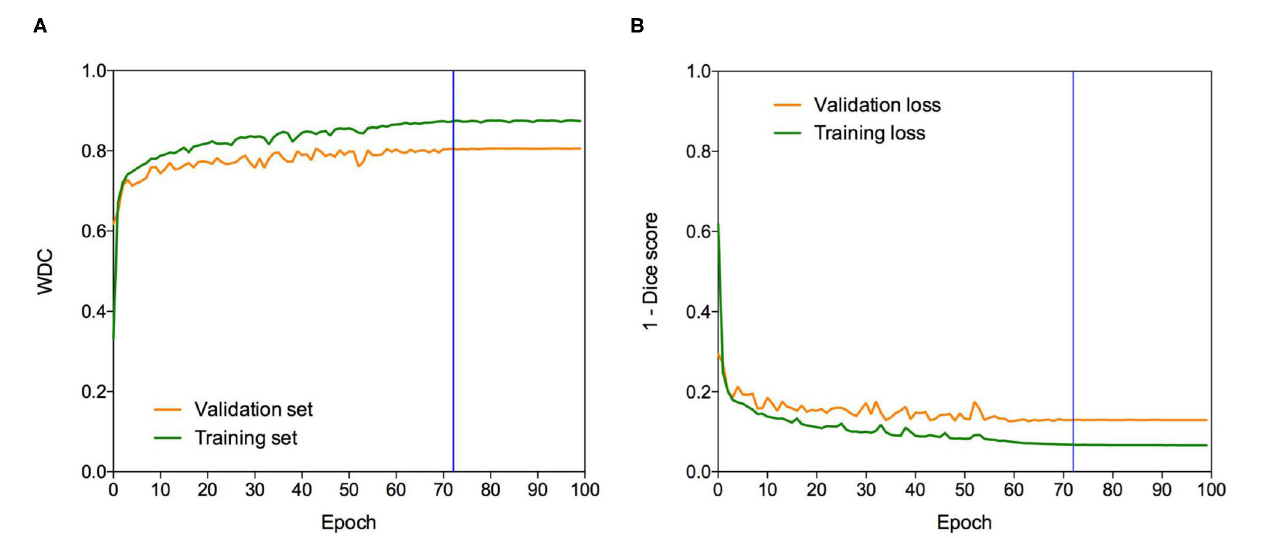
FIGURE 3 | Learning curves. Example of (A) WDC evaluation metric and (B) (1-Dice score) loss function evolution during training on the BraTS 2019 dataset. The blue vertical line shows the moment at which the model reached the best performance in the validation dataset. The best models were obtained systematically before the 100